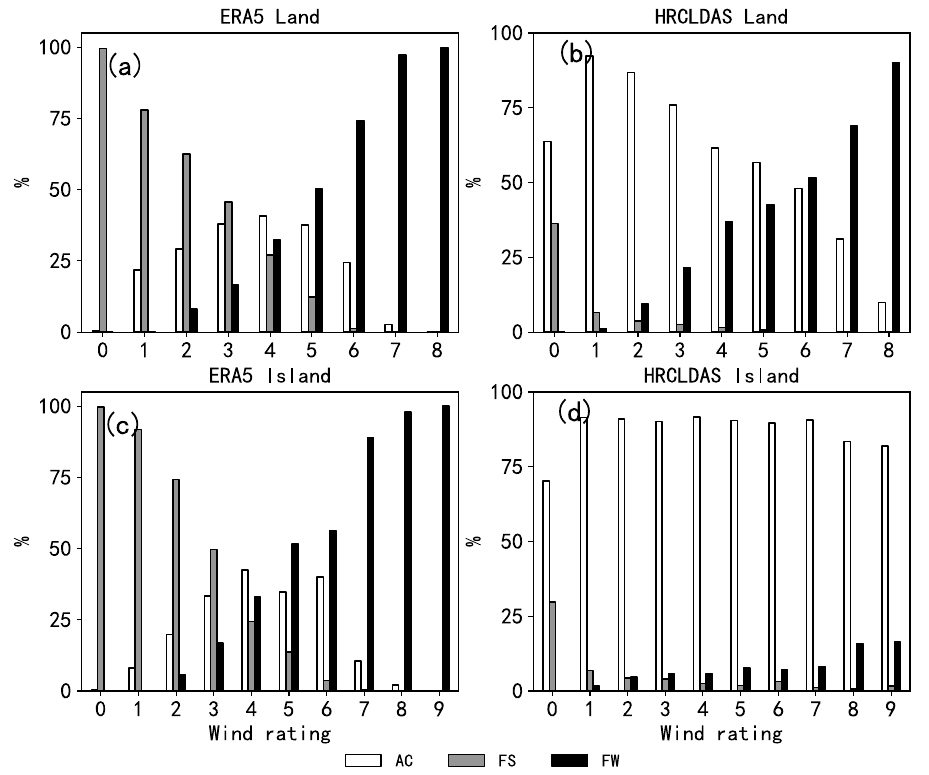
Figure 10. Wind grade accuracy rate, strong rate, and weak rate of ERA5 and HRCLDAS for the different underlying surfaces. ( a ) ERA5 on land; ( b ) HRCLDAS on land; ( c ) ERA5 on islands; and ( d ) HRCLDAS on islands.